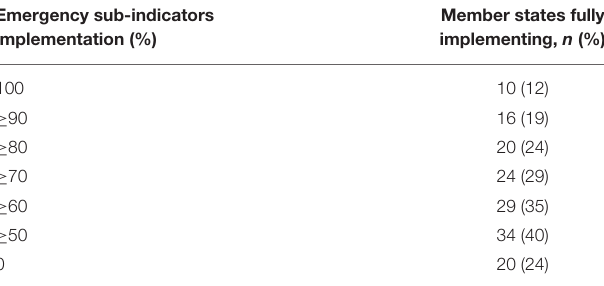
TABLE 4 | Full implementation of WHO global benchmarking tool sub-indicators relevant to public health emergencies among 84 member states benchmarked from 2016 to